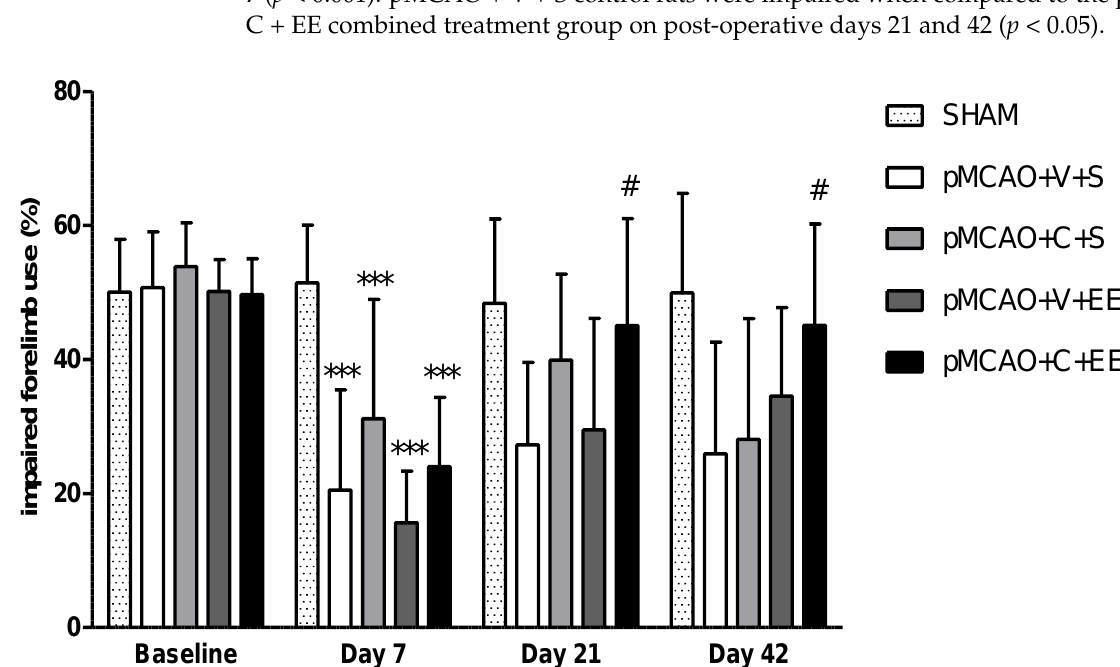
Figure 1. The spontaneous use of the impaired forelimb during vertical exploration was assessed with the cylinder test. There was a significant overall group effect ( p < 0.001), time effect ( p < 0.001), and time × group interaction ( p < 0.001). Statistical significance at days 7, 21, and 42: *** p < 0.001 (compared to pooled SHAM group), # p < 0.05 (compared to pMCAO + V + S) (one-way analysis of variance (ANOVA) followed by Bonferroni multiple comparisons test). Data are expressed as mean ± standard deviation (SD). SHAM = sham-operated; pMCAO = permanent middle cerebral artery occlusion; V = 48 h vehicle administration; C = 48 h cell administration; S = standard housing; EE = enriched environment.